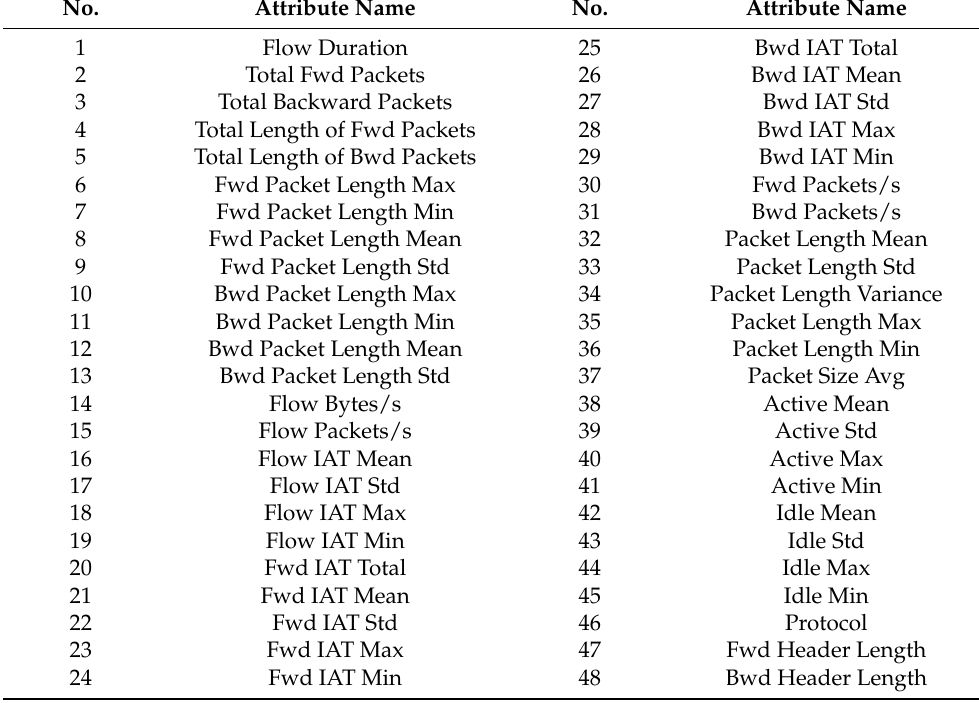
Table 7. Forty-eight subsets of